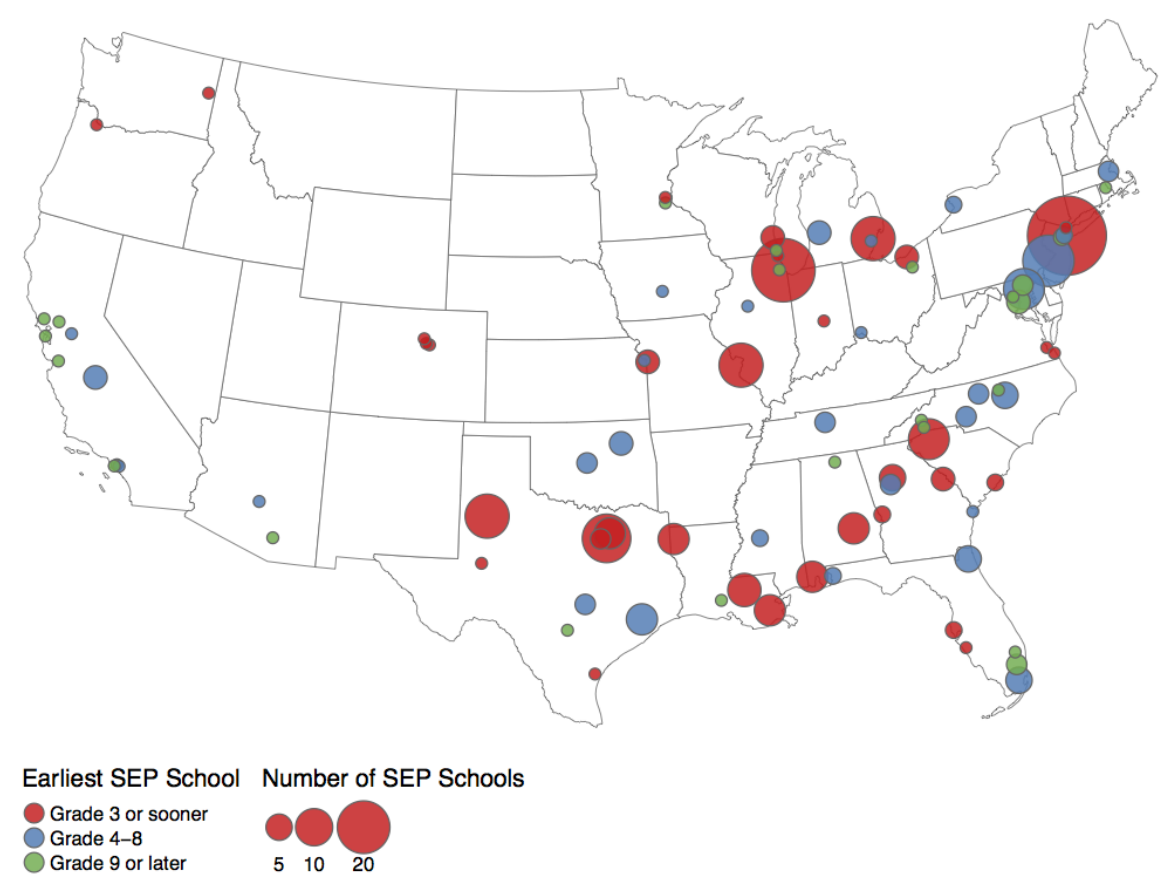
Figure 2: SEP schools: location, level, and